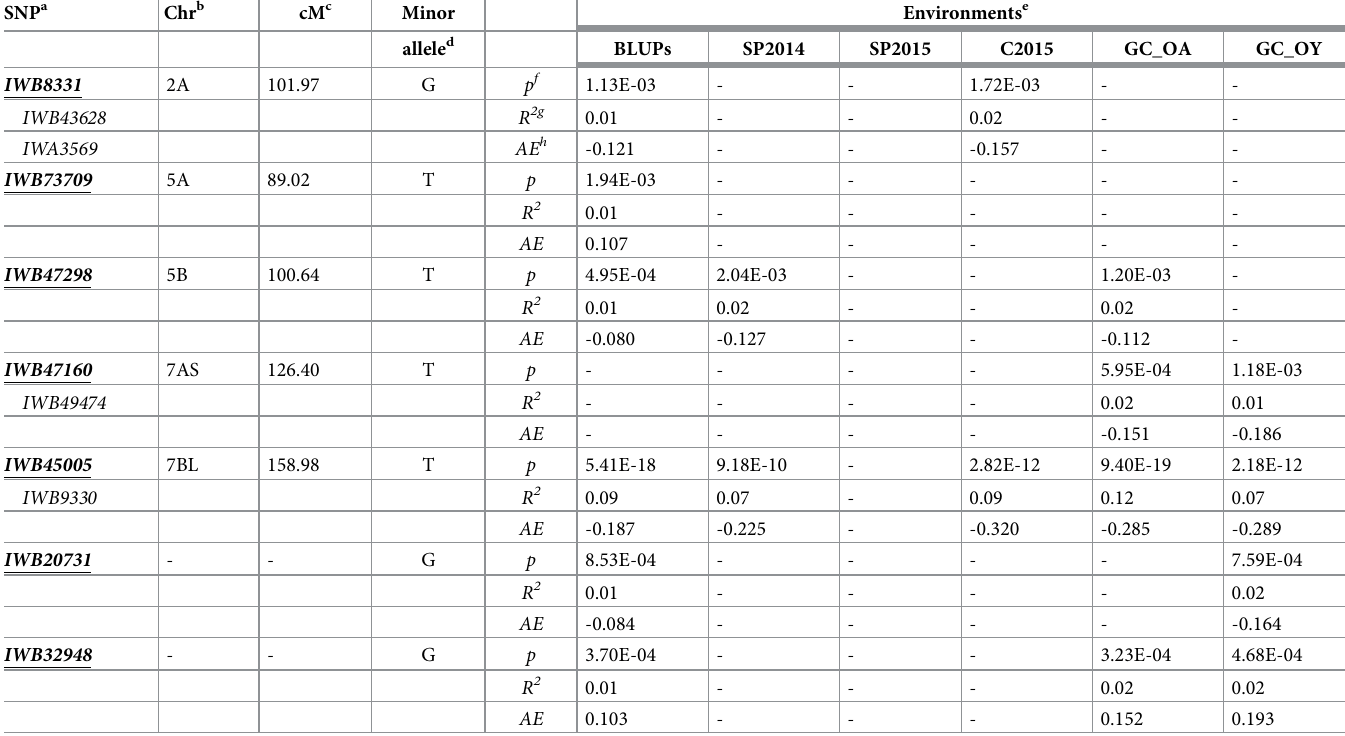
Table 1. Genome-wide association mapping (GWAS) analysis results for eyespot disease resistance in winter wheat Panel A. Markers associated with eyespot disease resistance with a p -value (cid:20) 0.005 and identified in two or more environments including BLUPS, are reported. SNP a Chr